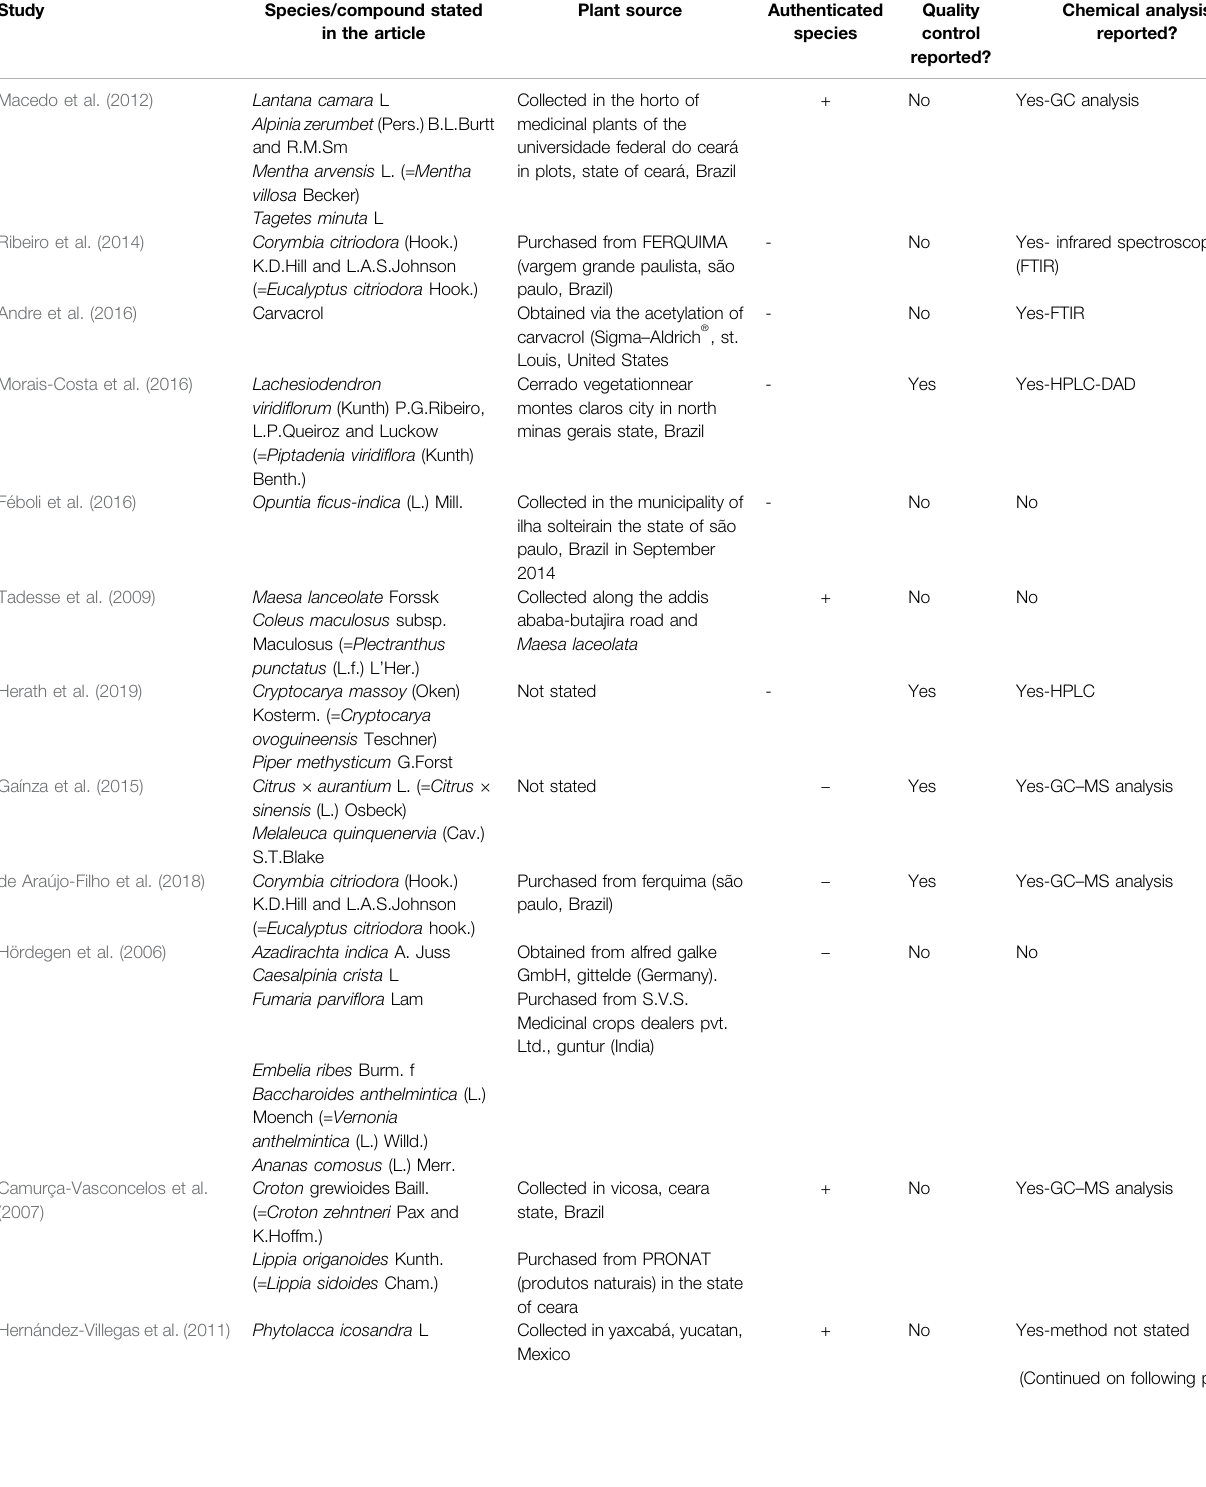
TABLE 1 | ( Continued ) Quality assessment of the articles selected for this systematic